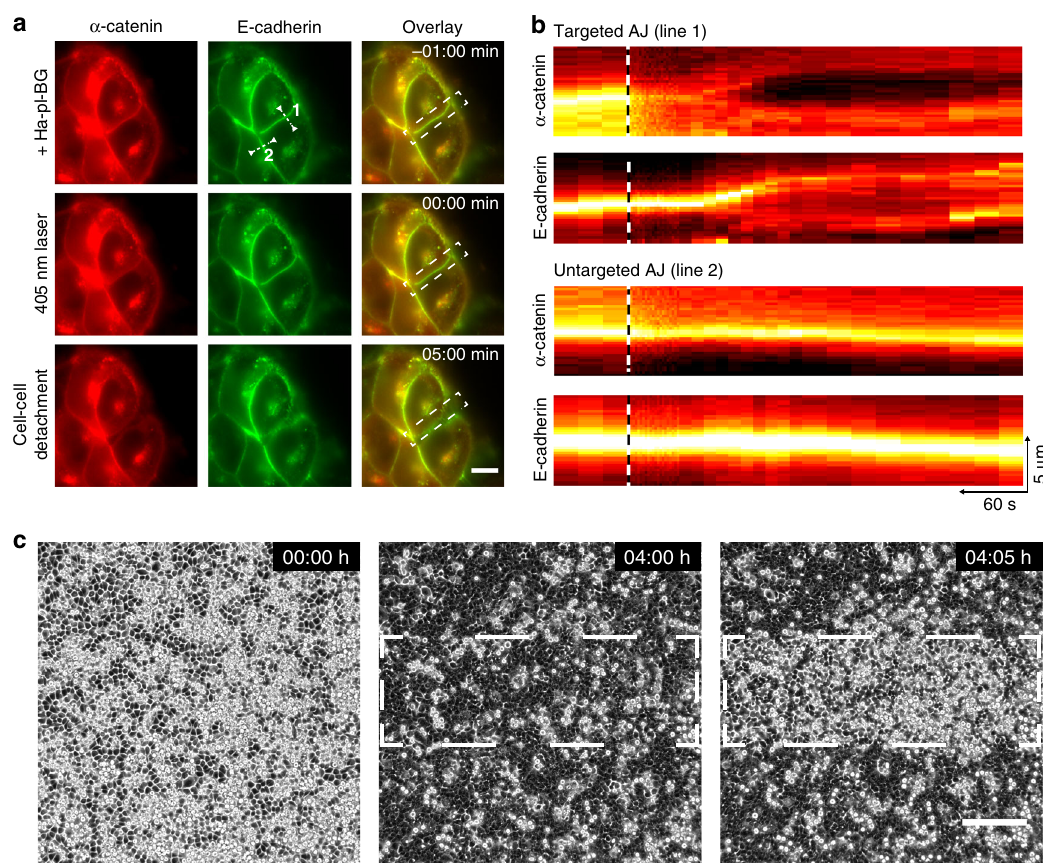
Fig. 3 Multiscale targeting of AJs assembly and disassembly with high spatial precision. a For visualization in live cell experiments, E-cadherin (shown in green) and α -catenin (shown in red) are tagged with GFP and mCherry, respectively. Targeted dissociation of Ha-pl-BG reconstituted AJs with subcellular precision before (upper row) directly after (middle) and 5 min after 405 nm laser area scanning (white dashed rectangular in the overlay). Scale bar 10 µ m. b Kymograph analysis of E-cadherin and α -catenin intensities of targeted (line 1) and untargeted (line 2) AJs in a . The time point of laser scanning is indicated as black and white dashed lines. Scale as indicated by arrows in the lower right. c Monolayer compaction via AJ reconstitution after addition of Ha-pl-BG leads to reintegration of the loosely attached cells in a monolayer. After 4 h, the white dashed outlined area was scanned with a 405 nm laser. Note that only cells in the targeted area change their morphology and push out excess cells immediately. Scale bar 200 µ dimerizer (Fig. 4c fi rst row), the intermediate fi lament protein cytokeratin is loosely associated with E-cadherin aggregates that form tethers between adjacent cells, but do not accumulate desmoplakin i.e., do not form stable desmosomal contacts. In